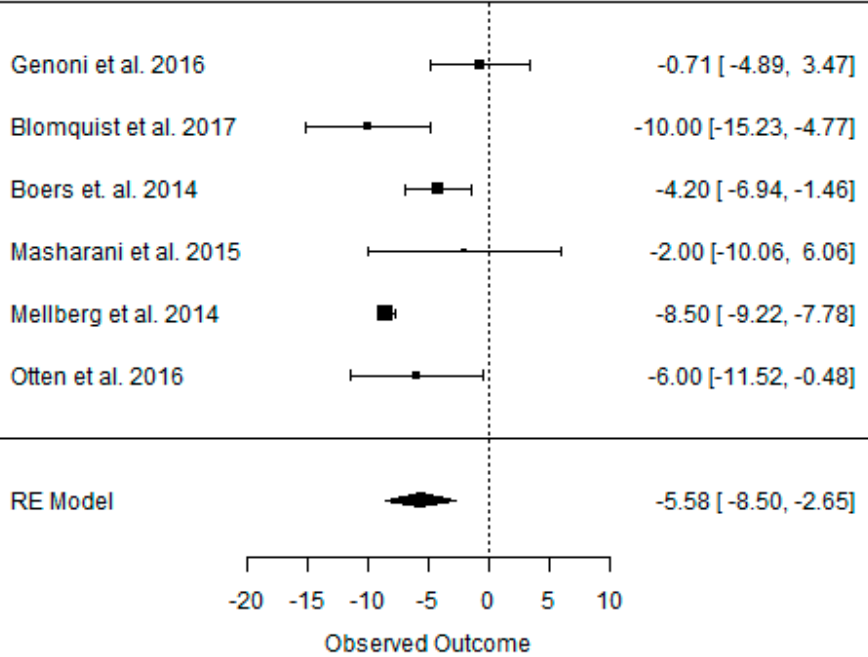
Figure A36. Forest plot of the effect of a CD on SBP in the short term (weighted mean difference).